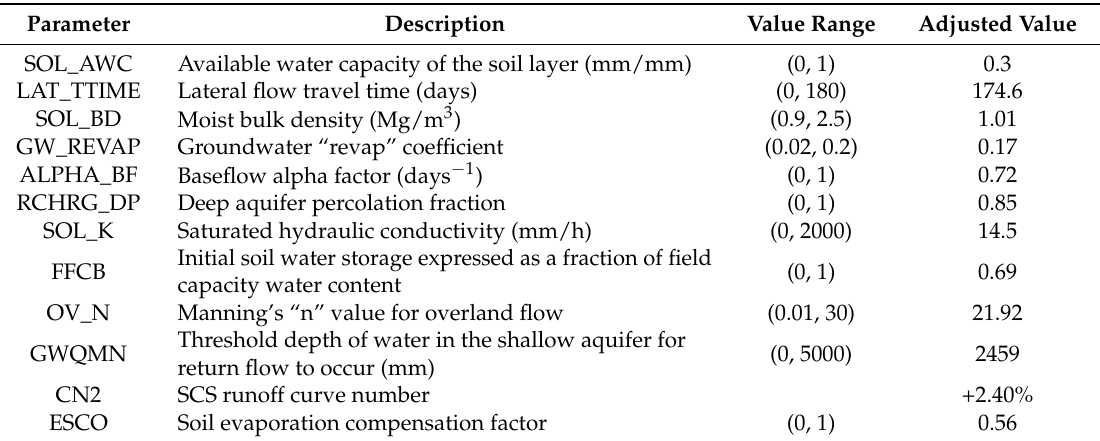
Table 3. Range and final parameter values after